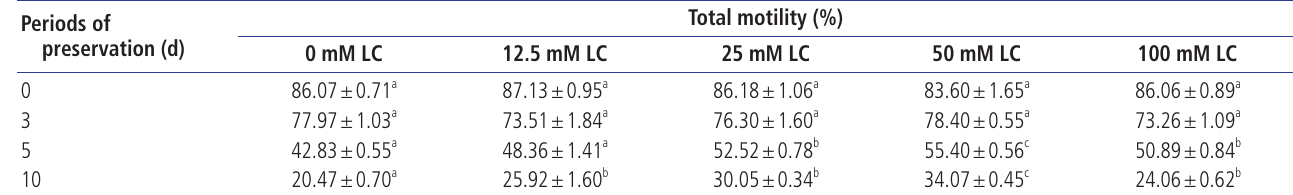
Table 1. Effect of L-carnitine on boar sperm motility during preservation Periods of preservation